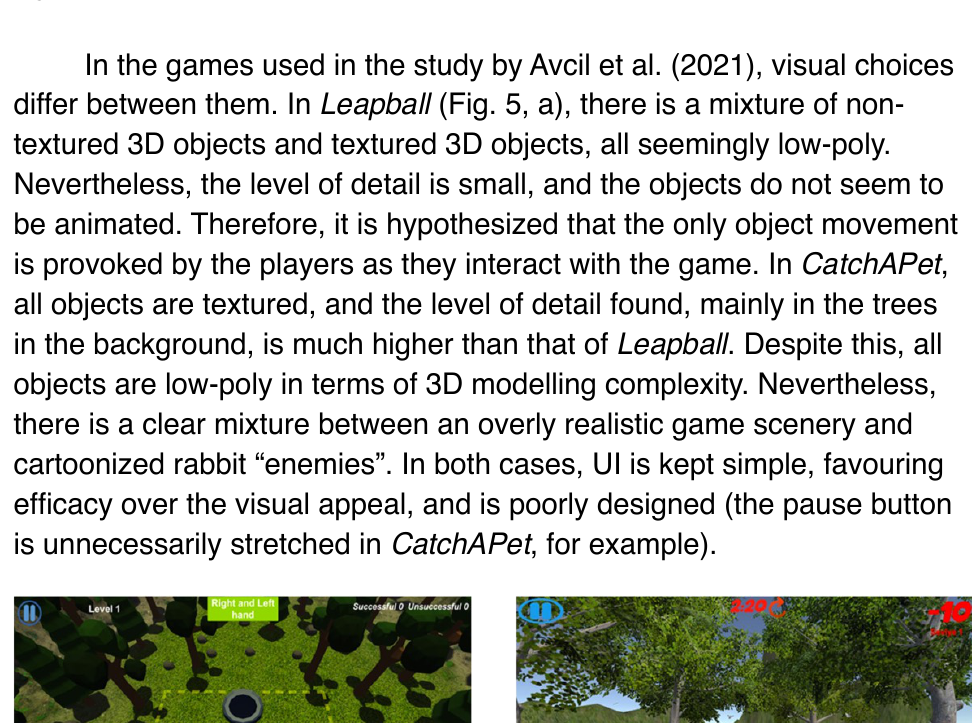
Fig. 4. Jintronix Games (Norouzi-Gheidari et al.,